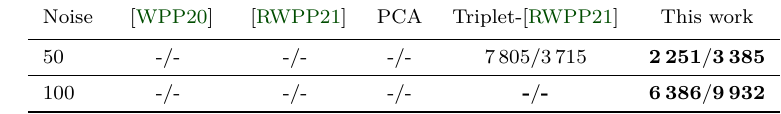
Table 7: Benchmark the attack performance ( T GE 0 ) with the ASCAD_R dataset perturbed with desynchronization. Attack results for the HW and ID leakage models are separated by